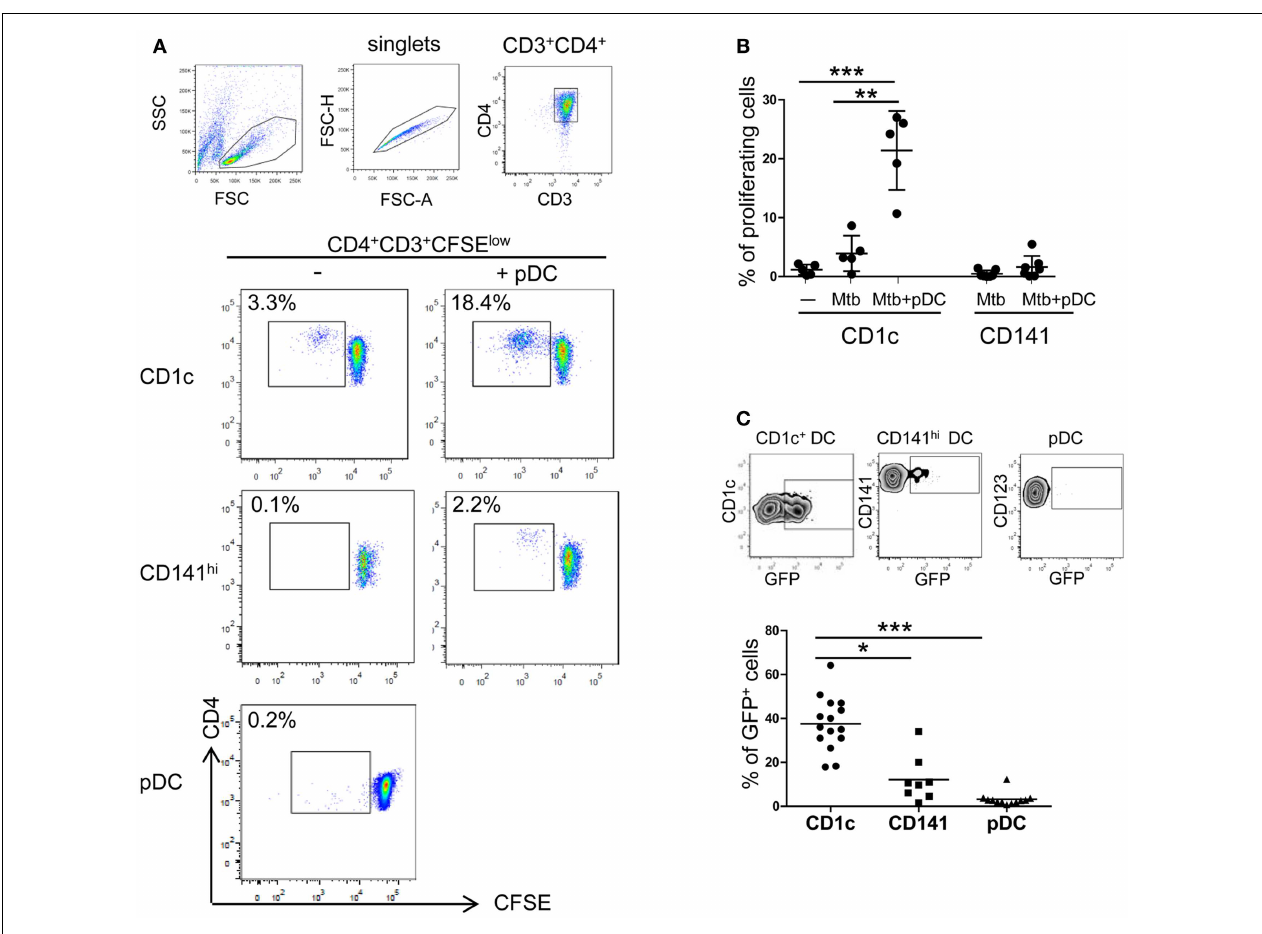
FIGURE 4 | CD4 + T cell activation by CD1c + DCs . (A) and (B) Naïve CD4T cells were labeled with CFSE and proliferation was measured after 7days of culture in the presence of autologous CD1c + DCs ± pDCs (CD1c), CD141 hi DCs ± pDCs (CD141 hi ), or pDCs alone (pDC) previously stimulated with live Mtb for 16h. DC:T cell ratio was 1:10. (A) One representative flow cytometric CD4T cell staining shown; lymphocytes were gated according to morphological parameters and doublets excluded. Proliferating CD4 + T cells were gated as CD4 + CD3 + CFSE low cells. (B) Mean ± SD of proliferating CD4 +